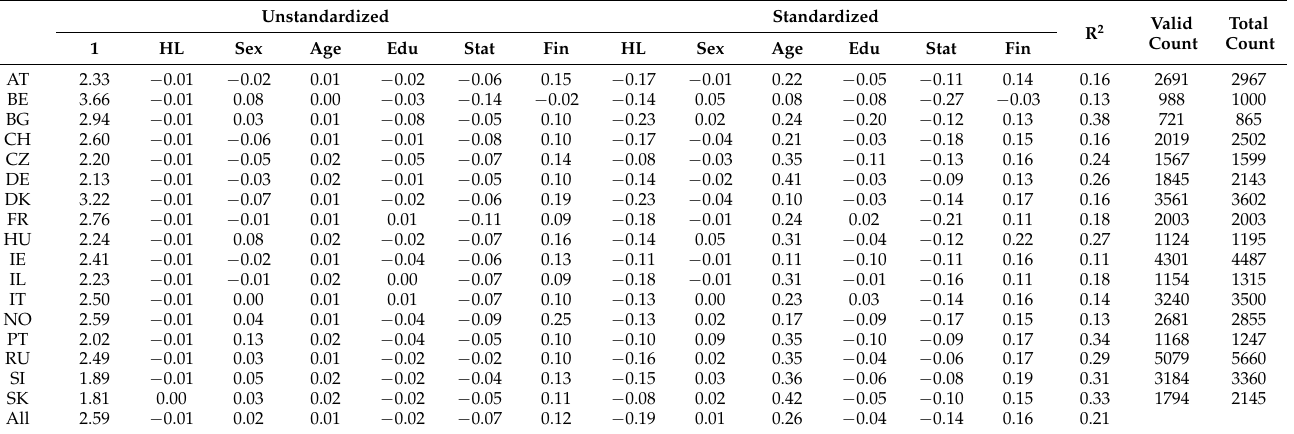
Table 16. Multivariable linear regression models of self-perceived health by general HL (P type) and five core social determinants (standardized coefficients ( β ) and R 2 ), for each country and for all countries (equally weighted).